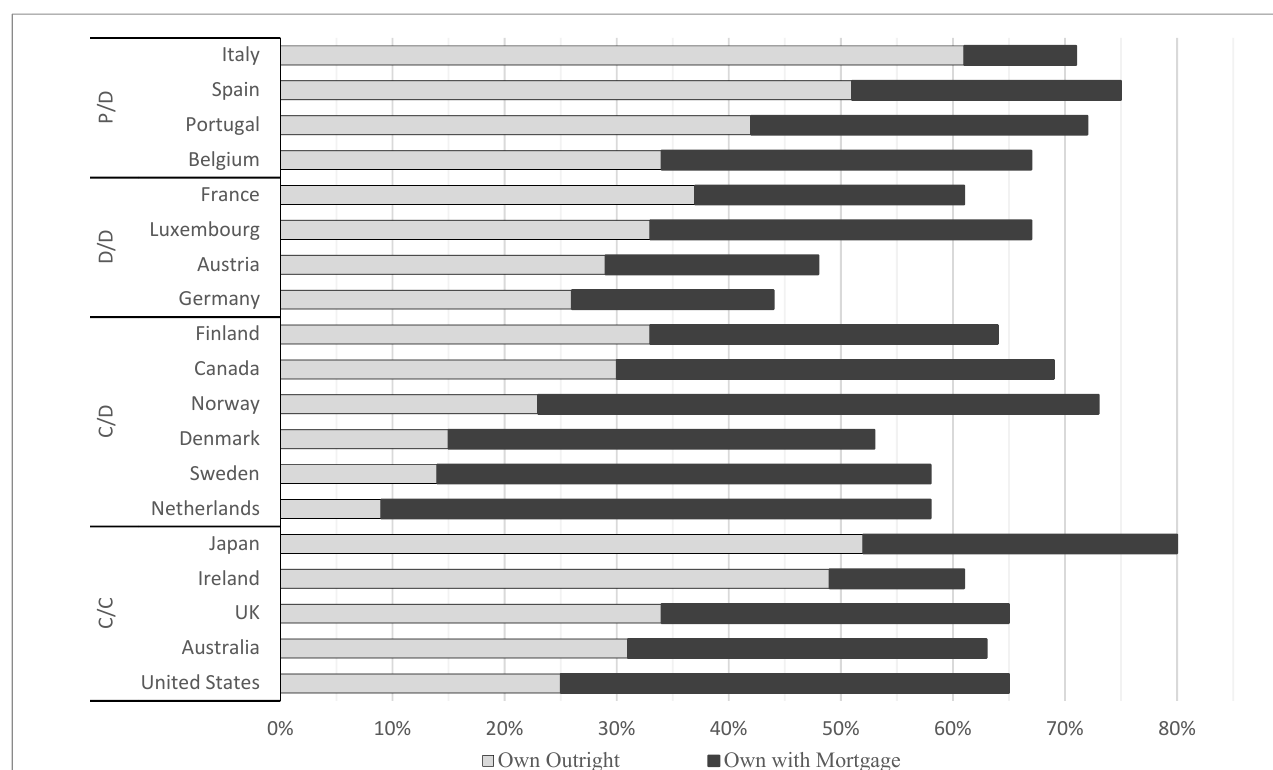
Figure 1. Homeownership rate by nation. Owners with a mortgage vs. outright owners, 2019. Source: (OECD 2019; OECD Affordable Housing Database 2021b). Note: Mortgage breakdown of those with and without a mortgage not available for New Zealand.